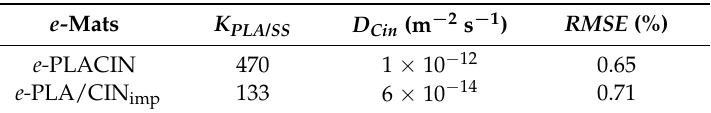
Partition and diffusion coefficients and root mean square error (RMSE) values of cinnamaldehyde from different active mats in EtOH 50% at 40 ◦